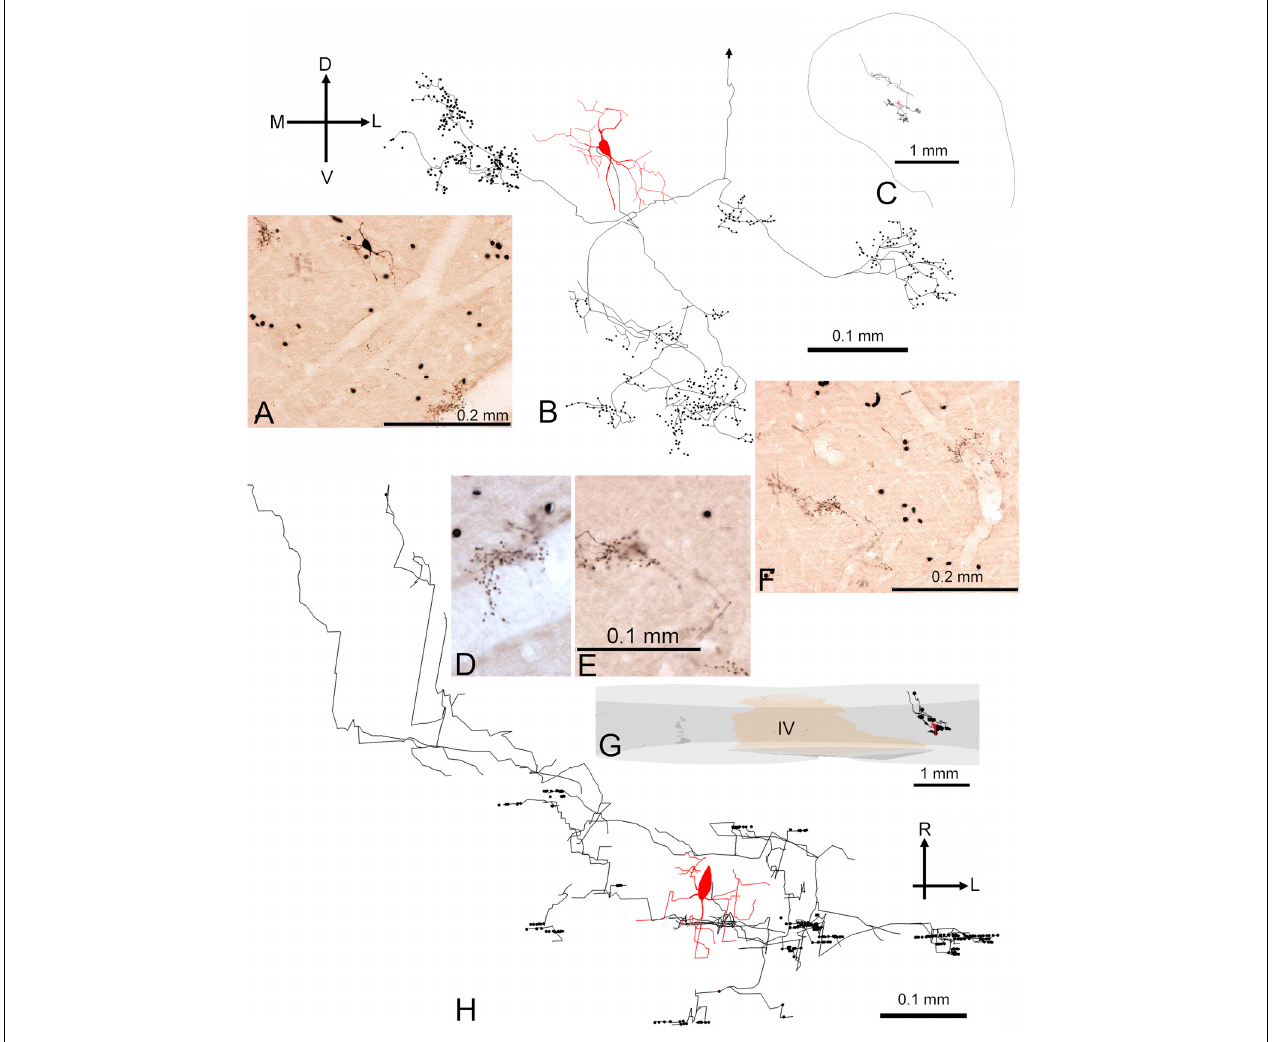
FIGURE 10 | Morphology of medium flat disk cell (350R) with basket–like axonal endings and a chopper response. (A) Photograph of stellate soma and the nearby clusters of axonal endings that look like bunches of grapes. (B) Coronal reconstruction of the stained cell showing the main clusters of axonal endings in relation to the soma. The dorsal part of the axon is not shown and its truncation point is indicated by an arrow. (C) Inset showing the position of the soma and axon in relation to the surface of the IC in a coronal section at the level of the caudal axonal endings. (D) Higher-power photograph of clusters of axonal terminals shown at the base of panel (A) . (E) Higher-power photograph of clusters of axonal terminals shown at the base of panel (F) . The scale bar applies to panel (D) as well. (F) Photograph of three clusters of terminals ventral and lateral to the soma. (G) Inset in the horizontal plane showing reconstruction of the cell in relation to the medial borders of the two sides of the inferior colliculus and the IVth ventricle (IV). (H) Reconstruction of the complete neuron shown in the horizontal